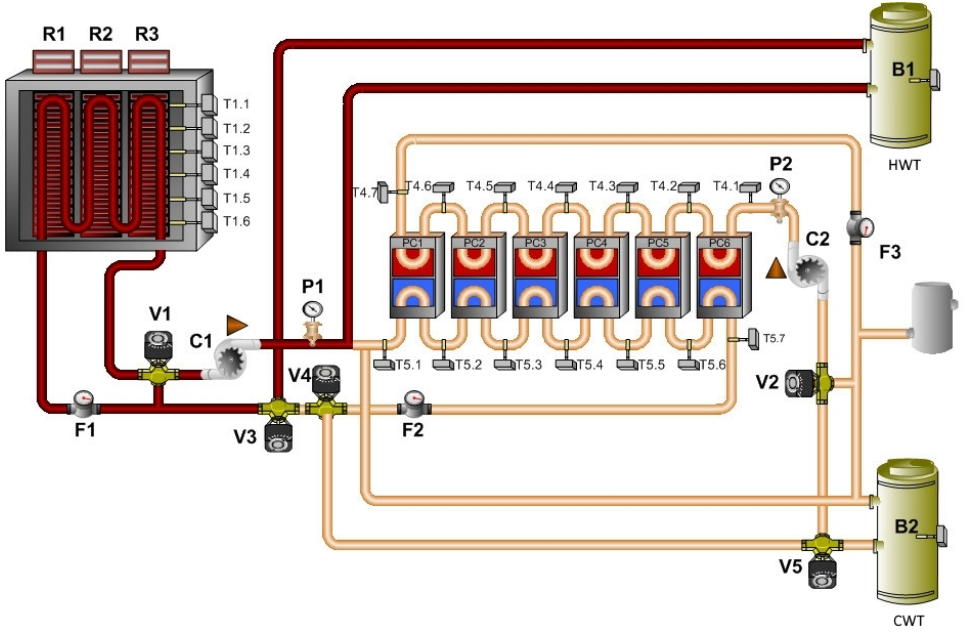
Figure 7. Mode: heating of thermal